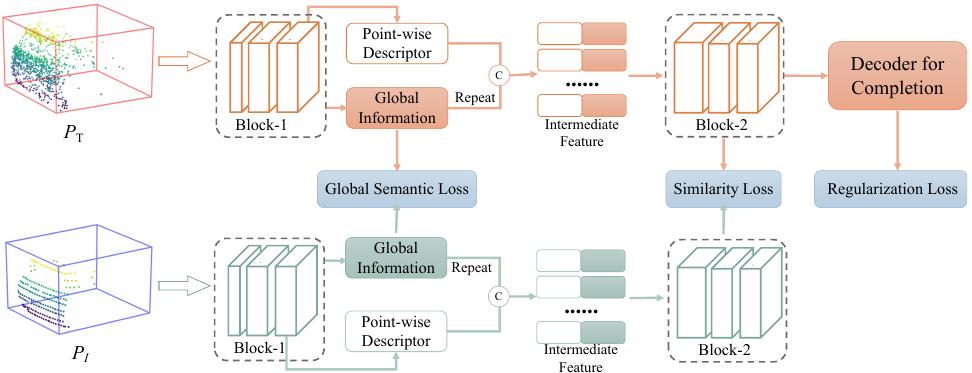
Figure 4. The scheme of our TDS. Its feature backbone is composed of two blocks as same as the SES. Particularly, the global feature generated from Block-1 is repeated and concatenated with each point-wise feature. Afterwards, the intermediate aggregation feature is further fed into Block-2. Finally, we use the combination of similarity loss, global semantic loss, and regularization completion loss to train the